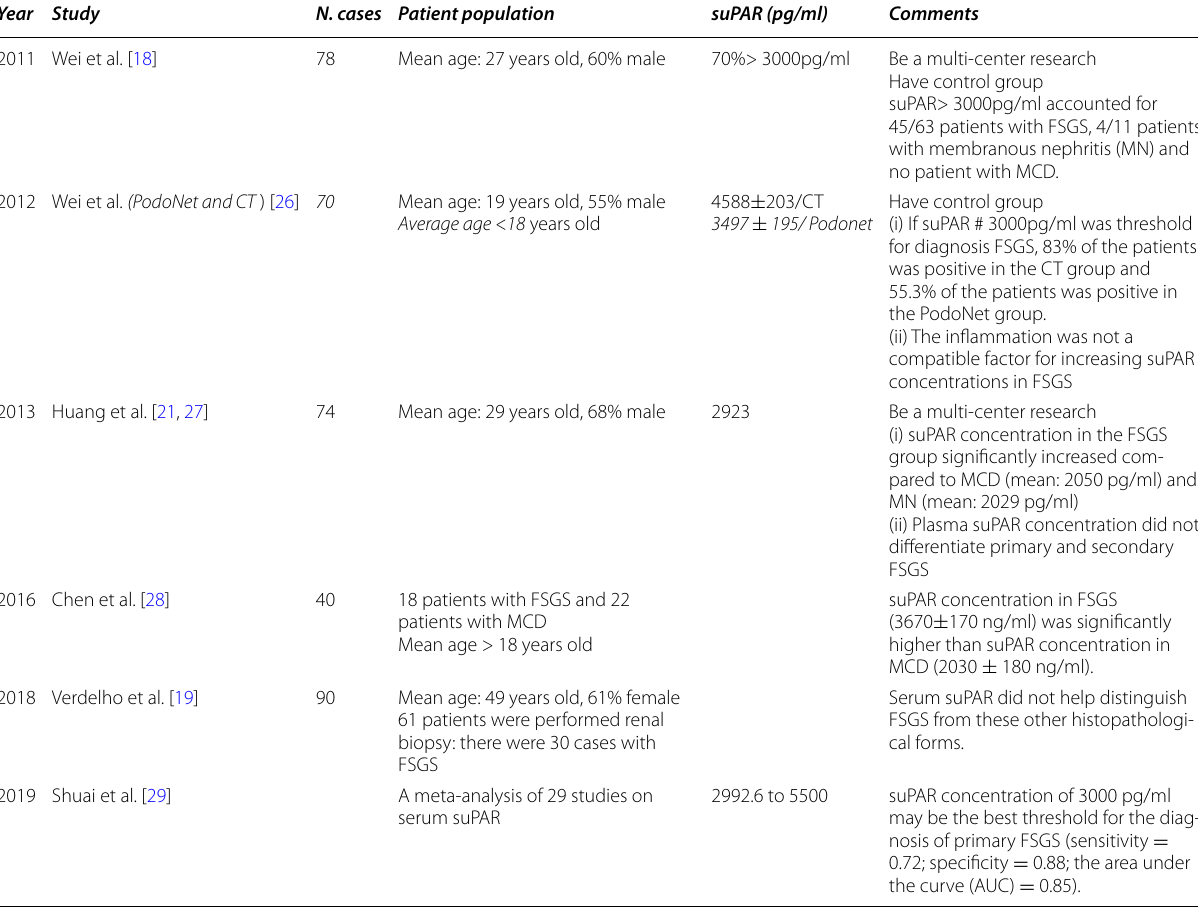
Table 2 Summary of studies on suPAR related to FSGS